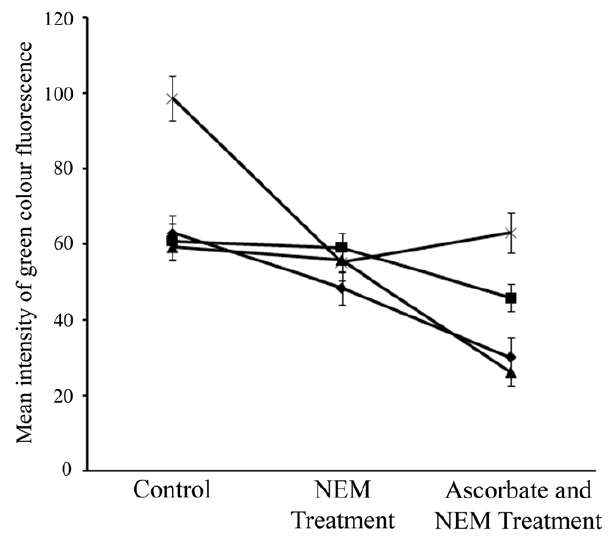
Figure 4. RSNO fluorescence intensity profile of nodules from A.hypogaea JL 24 and M.sativa . The mean intensity of green colour (as observed in Figure 2 and 3) of nodule sections was plotted for control, those were blocked with L-NEM and those were reduced with ascorbate and were blocked with L-NEM. This was done for both the A. hypogaea JL 24 (— ¤ — 20 day, — & — 40 day and — m — 80 day old nodule) and M. sativa (— 6 — 143 day old nodule). Results were expressed as mean 6 SD, for n=3 experiments.